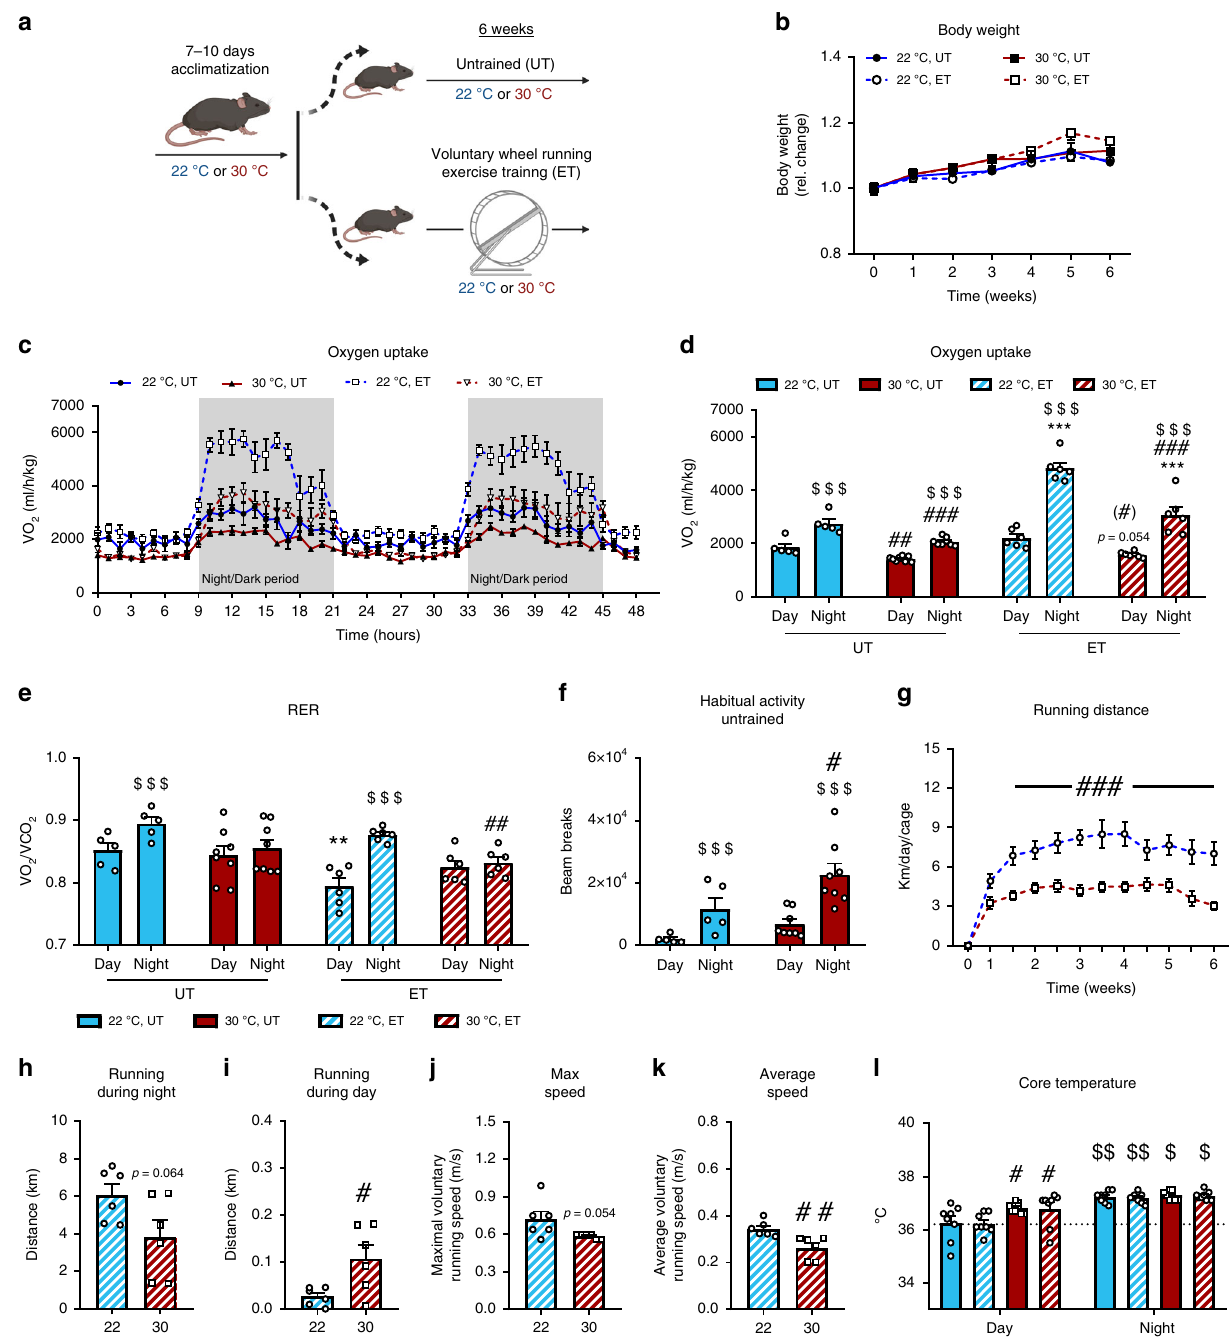
Fig. 1 Thermoneutral housing lowers energy expenditure and metabolic fl uctuations in exercising mice. a Graphic illustration of the experimental exercise training model. Mice were acclimatized to housing temperature before completing a 6 weeks voluntary wheel running exercise training (ET) intervention. (UT = untrained). b The effect of housing temperature and ET at 22 °C and 30 °C on body weight. Statistical testing; Two-way ANOVA (repeated measures). 22 °C UT; n = 8, 22 °C ET; n = 10, 30 °C UT; n = 9, 30 °C ET; n = 10. c – e VO 2 and RER in UT and ET mice at 22 °C and 30 °C housing. Statistical testing; Two-way ANOVA (repeated measures). 22 °C UT; n = 5, 22 °C ET; n = 6, 30 °C UT; n = 8, 30 °C ET; n = 6. Effect of time within group; $$$ p < 0.001. Effect of temperature within time of day; # p < 0.05, ## p < 0.01, ### p < 0.001. Effect of ET within temperature; ** p < 0.01, *** p < 0.001. f Habitual activity (2 consecutive days) in UT mice after 6 weeks temperature acclimatization. Statistical testing; Two-way ANOVA (repeated measures). 22 °C UT; n = 5, 30 °C UT; n = 8. Effect of time within group; $$$ p < 0.001. Effect of temperature within time of day; # p < 0.05. g Running distance per day at 22 °C and 30 °C, respectively. Statistical testing; Two-way ANOVA (repeated measures). n = 10. Effect of temperature; ### p < 0.001. h – k Effect of temperature on wheel running distance, maximum and average speed. Statistical testing; student ’ s t -test. 22 °C ET; n = 6, 30 °C ET; n = 6. Effect of temperature; # p < 0.05, ## p < 0.01. l Core temperature was measured at day (light period) and night (dark period) time via rectal thermometer. Statistical testing; Two-way ANOVA (repeated measures). n = 8 Effect of time, day vs. night; $ p < 0.05, $$ p < 0.01. Effect of temperature within day; # p < 0.05. Data are presented as mean ± SEM incl. individual values where applicable. The “ n = x ” de fi nes the number of biologically independent animals used for the